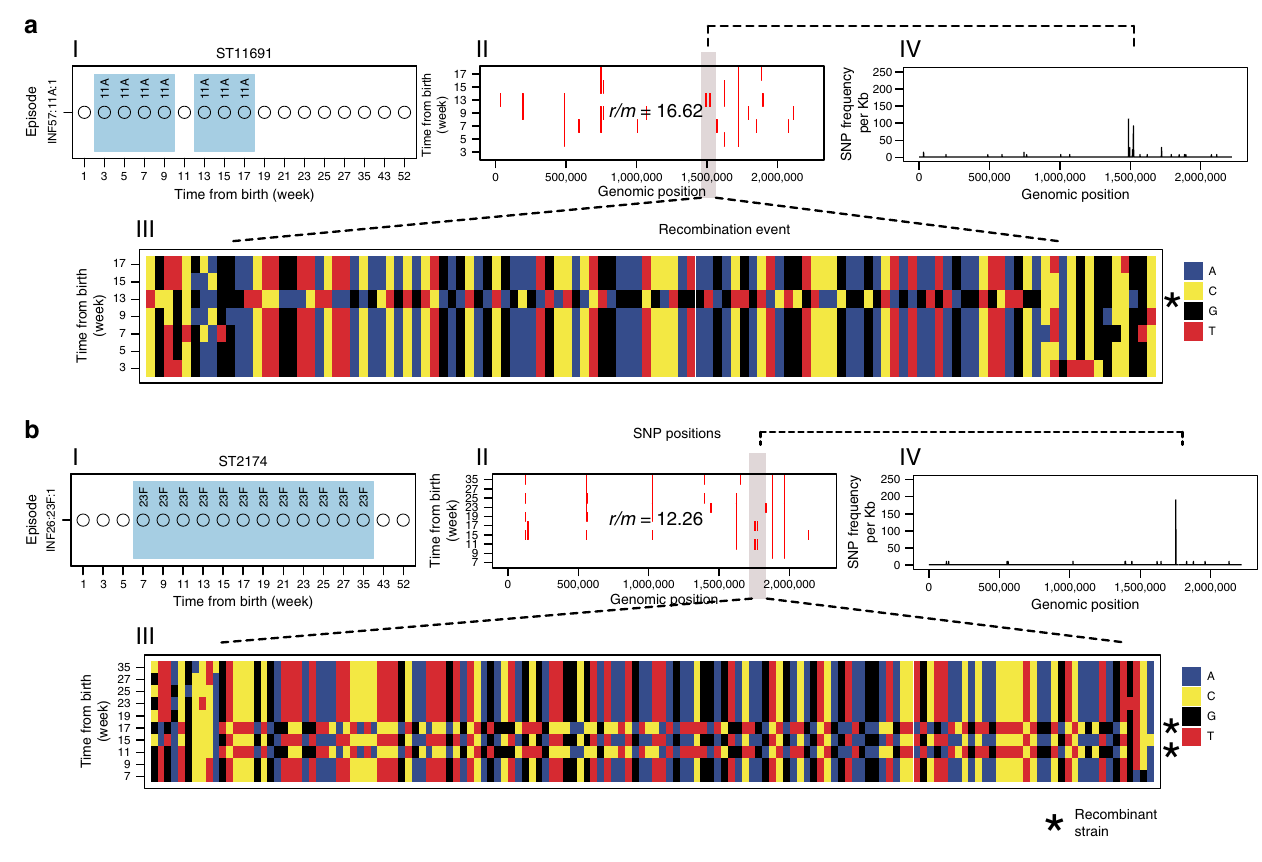
Fig. 4 Within-host homologous recombination during colonisation. a , b Two examples of colonisation episodes namely INF57:11A:1 and INF26:23F:1 respectively, where recombination blocks were detected. The episode name is shown in the format A:B:C where A,B and C represents the infant ID, serotype and number of episodes with the serotype respectively. (I) Colonisation episode showing the time points at which the serotype in the episode was detected. Some or all the detected samples were sequenced. In episode INF57:11A:1, serotype 11A was detected from week 3 to 17. A recombination block was detected at week 13 but the recombinant strain did not persist until the next sampling time at week 17. In episode INF26:23F:1, serotype 23F was detected from week 7 to week 35. Recombination block was fi rst detected at week 11 but it persisted, and the recombinant strain was sampled again at week 17. (II) Distribution of SNPs across genome of the serotype 11A and 23F in episodes INF57:11A:1 and INF26:23F:1 respectively. The coloured line (red) shows occurrence of a SNP in the strain using the fi rst sequenced genome in the episode as the reference or ancestral strain. The SNP are enhanced for clarity. (III) A multiple sequence alignment of showing location of the SNPs and visual evidence of the emergence of a recombinant strain within the episode. The value for r/m represents the number of SNPs within recombination blocks relative to SNPs outside the blocks. (IV) The distribution of the SNPs is highlighted by the frequency polygon, generated using widow size of 1000 bp, which shows spikes in the SNP density across the recombinogenic